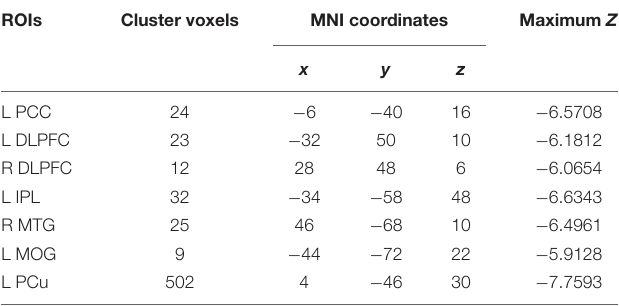
TABLE 2 | Altered regional cerebral blood flow (rCBF) in the AD patients. ROIs Cluster voxels MNI coordinates